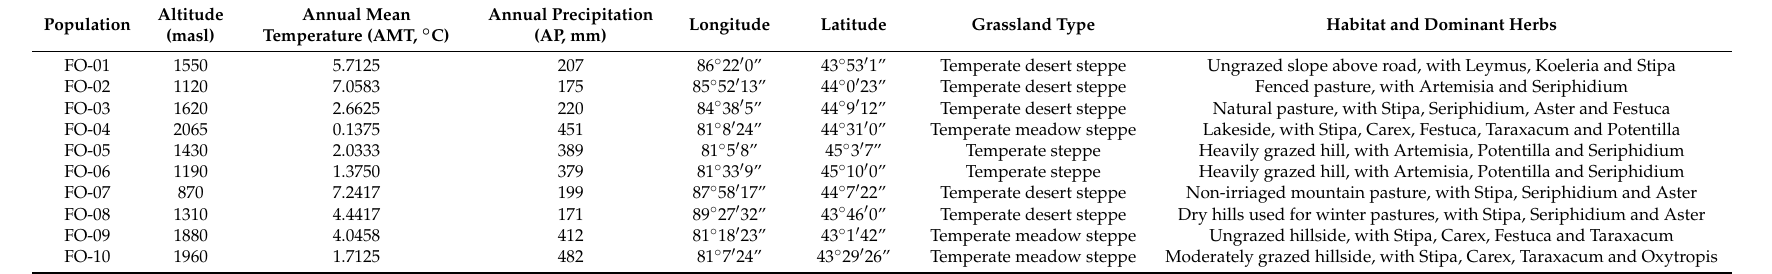
Table 6. List of the 10 wild F. ovina populations in this